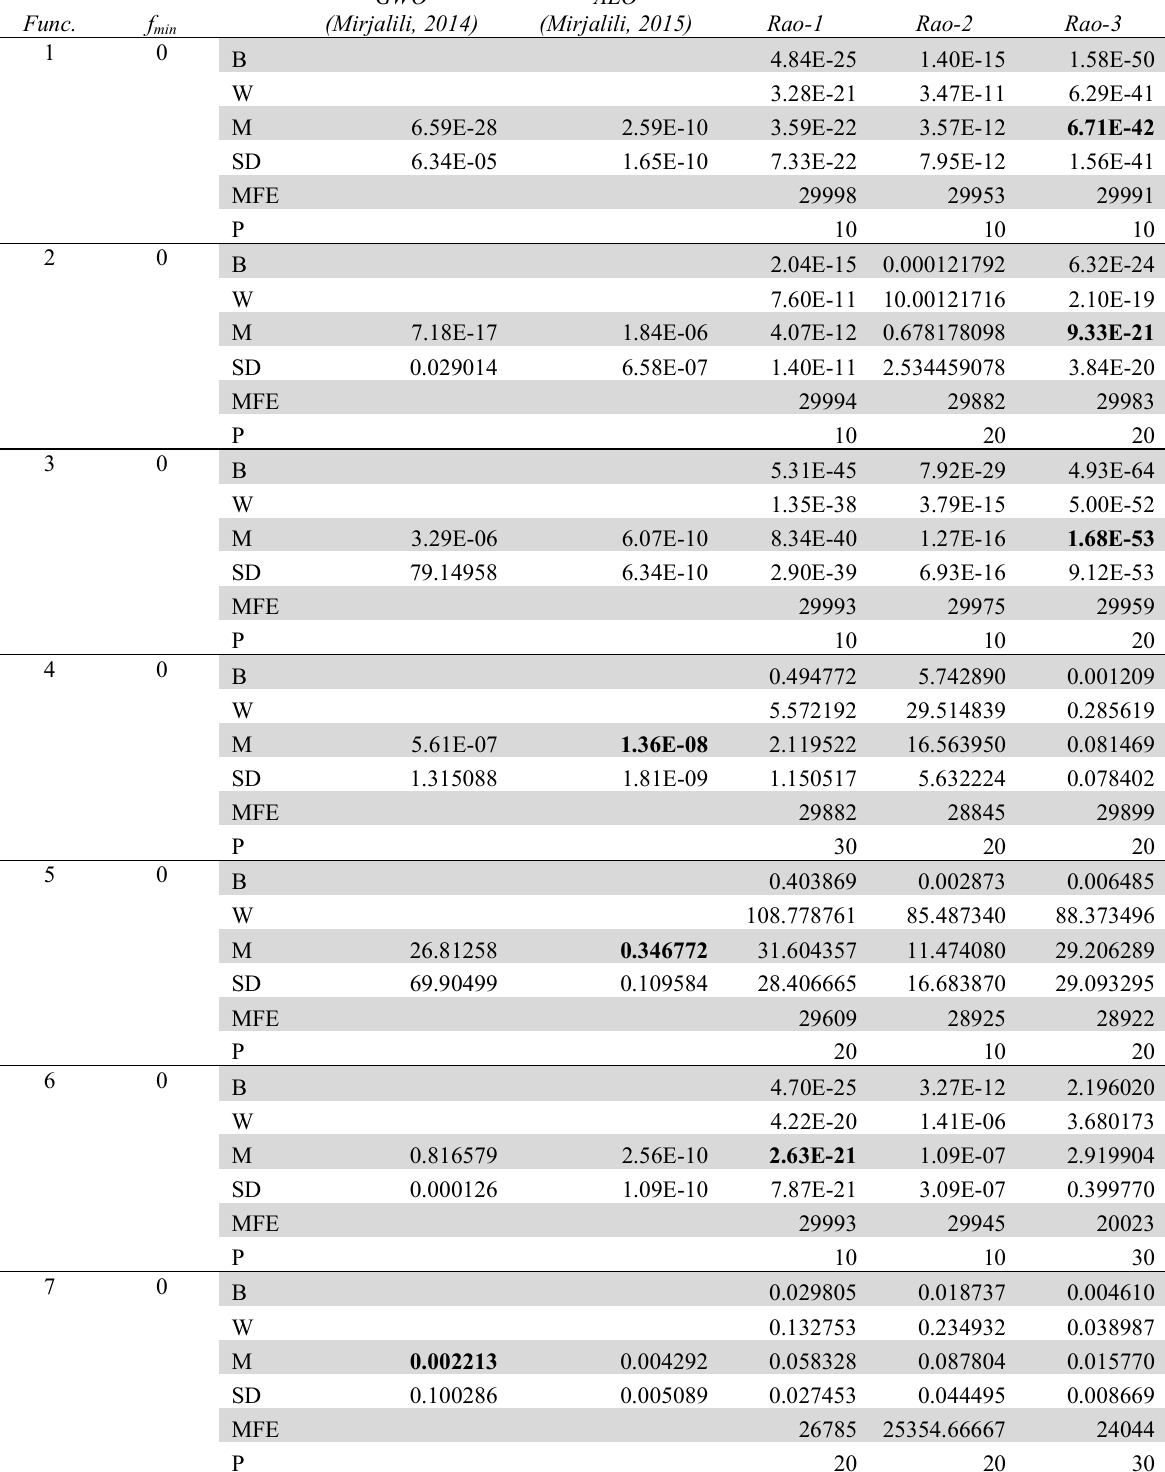
Results of the proposed algorithms for 23 benchmark functions considered (30000 function evaluations)